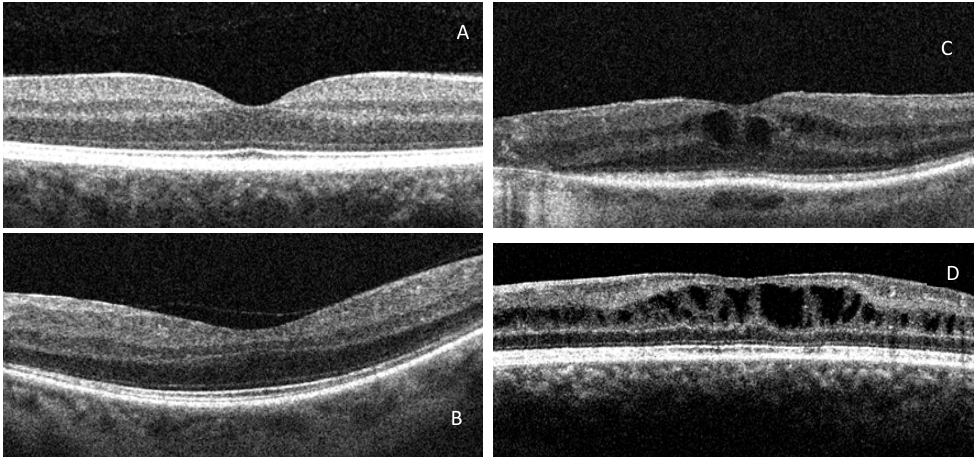
Figure 1. OCT groups: ( A ). Normal, ( B ). NMT, ( C ). DRT, ( D ). wDRT.